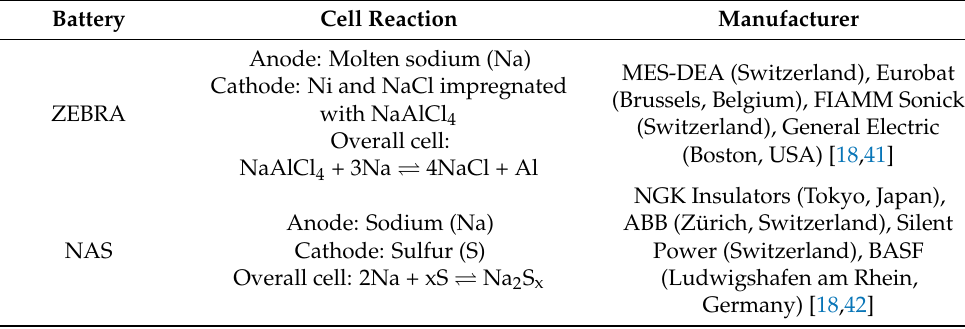
Table 5. Molten Salt batteries. Characteristics and